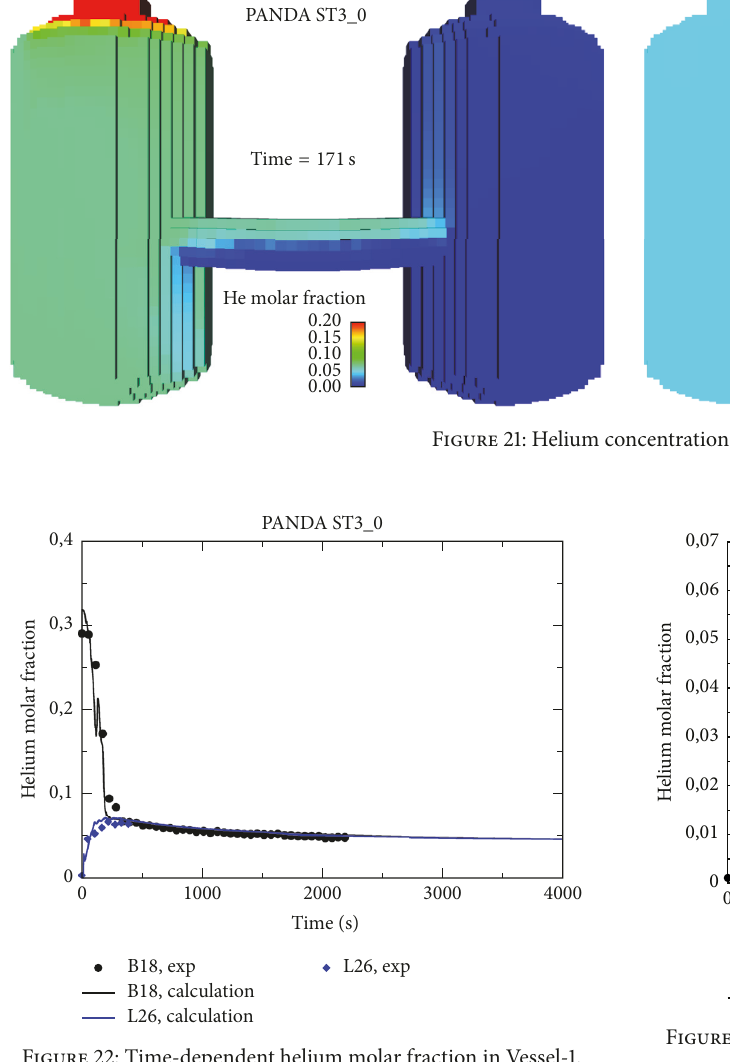
Figure 22: Time-dependent helium molar fraction in Vessel-1.